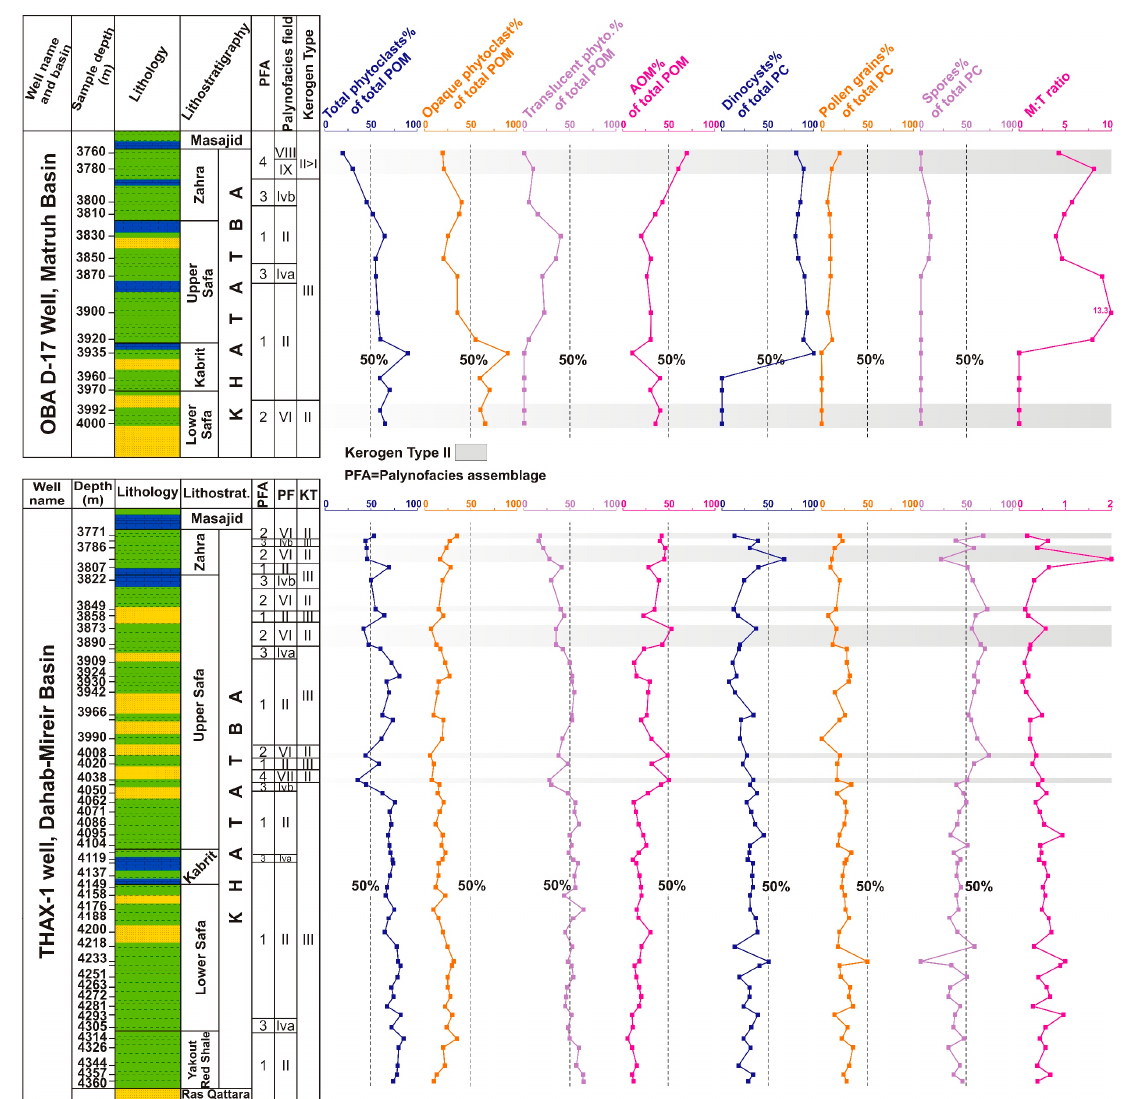
Figure 6. Stratigraphic distribution chart of kerogen parameters, palynomorph composition, and M:T ratios of the Khatatba Formation from the OBA D-17 and THAX-1 wells in the Matruh and Dahab-Mireir Basins, respectively.